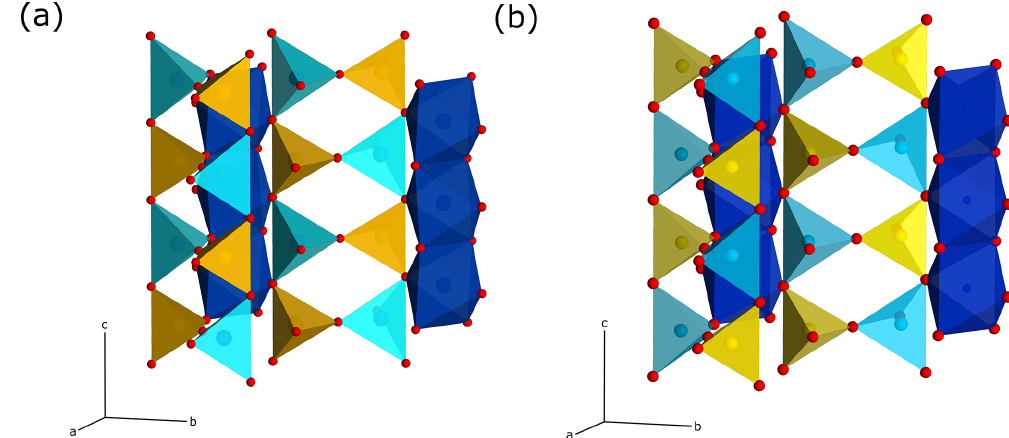
Figure 5. Crystal-structure representations of the sillimanite and mullite-2 c tetrahedral double chains. The left chains correspond to the chain 1 / 2, 0, z , and the right ones to chain 0, 1 / 2, z , in Fig. 4a. The colour coding of the polyhedra corresponds to that in Fig. 4. The double chains in the mullite-2 c structure are shifted against each other by an offset of 1 / 2 c compared to sillimanite. View direction is perpendicular to the c axis and is slightly rotated about c and b . (a) Sillimanite. (a) Mullite-2 c